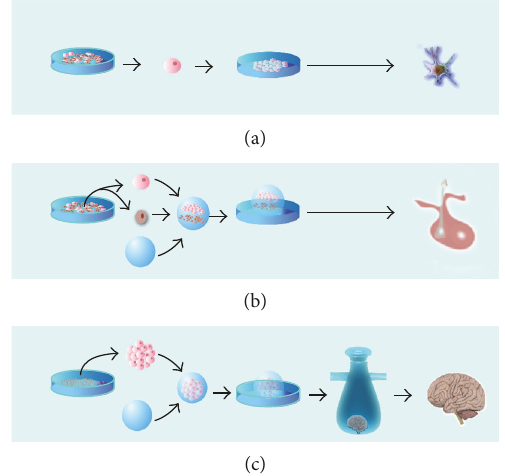
Figure 2: Schematic of three neural organogenesis approaches in vitro. (a) Stepwise, direct organization of region-speci fi c or population-enriched organoids; (b) assemble and direct distinct organ-speci fi c progenitor cells or stem cells to form speci fi c morphogenesis organ; (c) assemble embryoid bodies for induction of multilayer